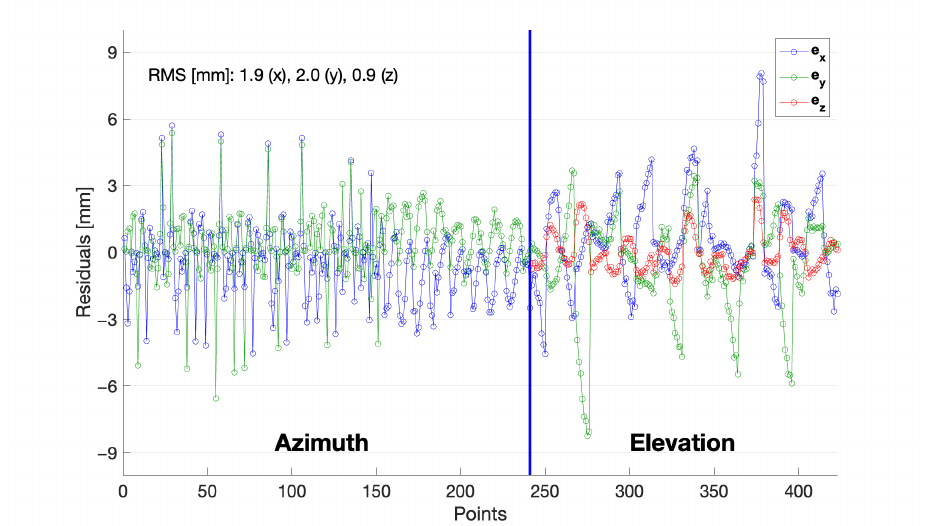
Figure 8. Residuals of each observation after TLS adjustment. The z -component is not involved in the azimuthal rotation, and the periodic large residuals are related to the vertical motion at specific azimuth.